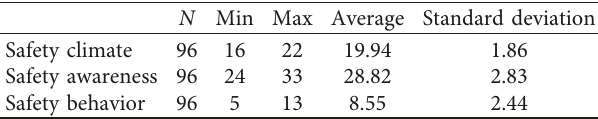
Table 1: The scores of safety climate, safety awareness, and safety behavior.